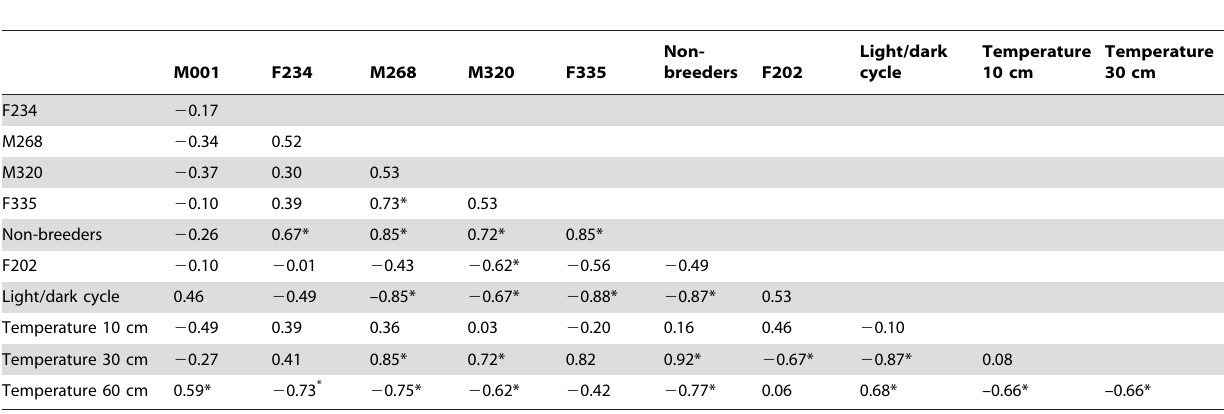
Table 2. Correlations between activity (proportions of outside-nest fixes) of radio-tracked giant mole-rats and environmental variables set for 12 2-h blocks of the 24-h